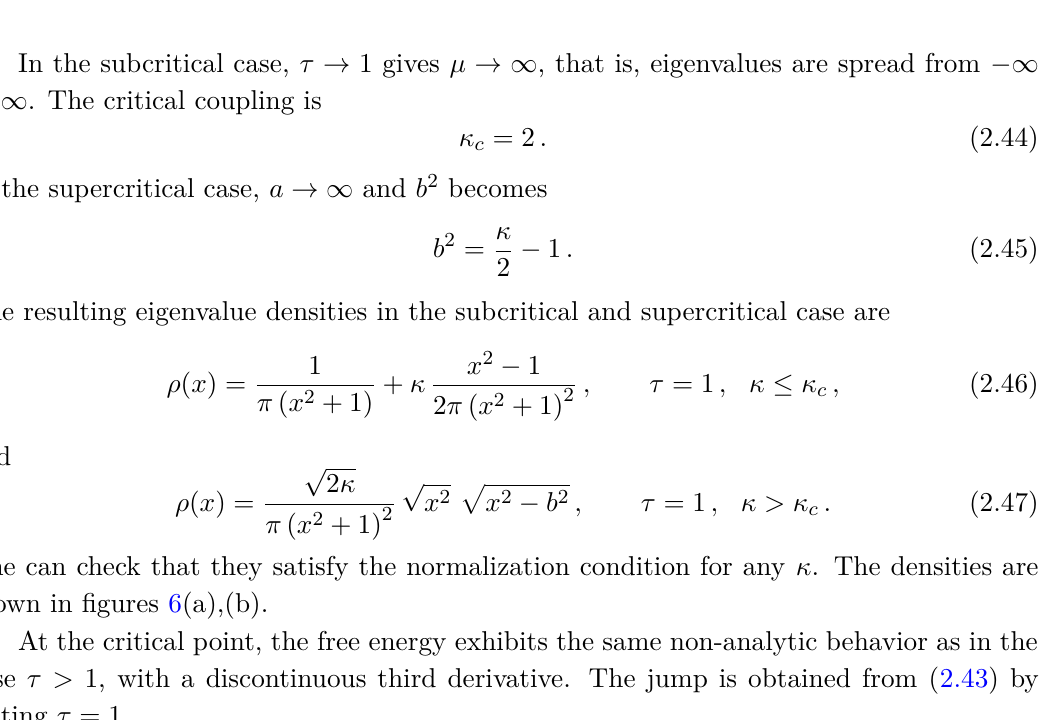
Figure 5 . The first derivative of the susceptibility is discontinuous, indicating a third-order phase transition. The figure corresponds to τ = 2 , in which case κ c ≈ 3 . 73